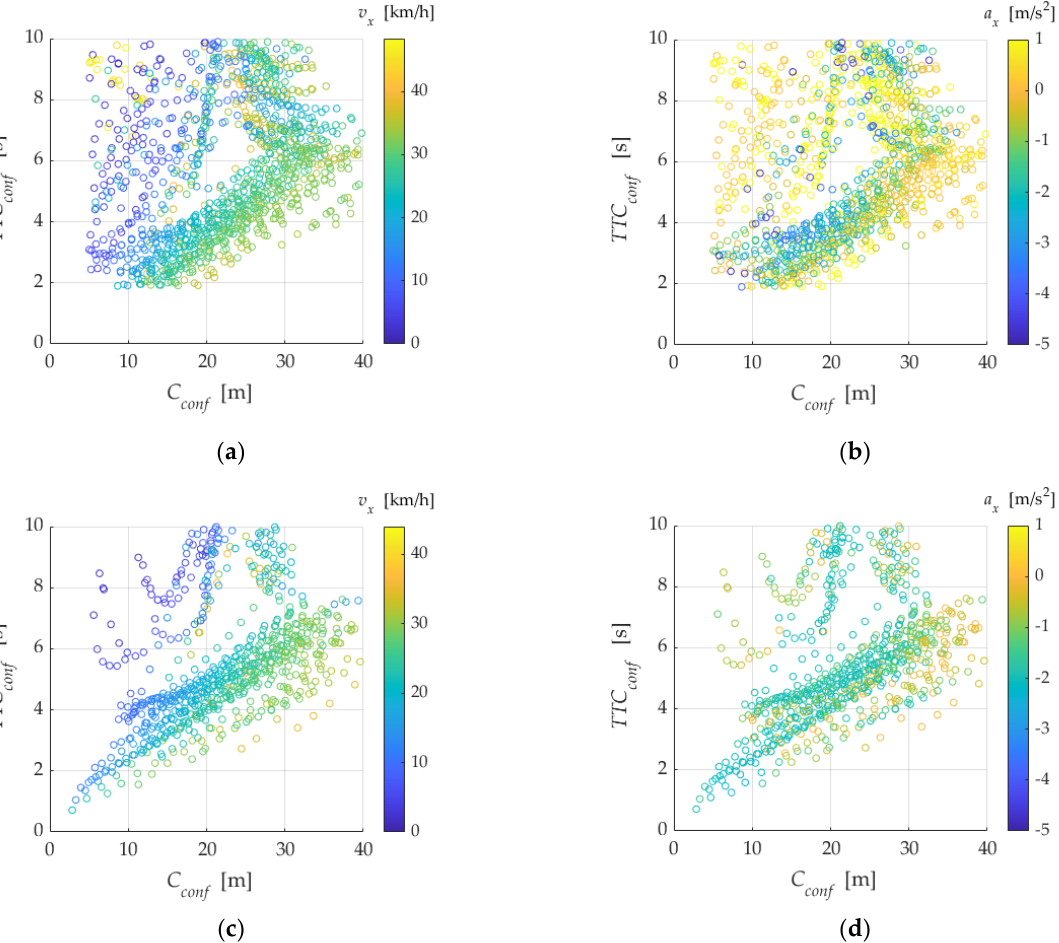
Figure 15. Simulation results of the Monte Carlo simulation: ( a ) Proposed algorithm in v x ; ( b ) proposed algorithm in a x ; ( c ) base algorithm in v x ; ( d ) base algorithm in a x .